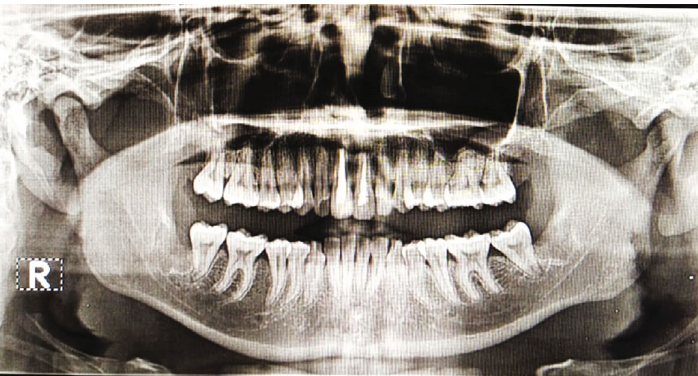
Figure 8: Radiographic examination 3 months postoperative.